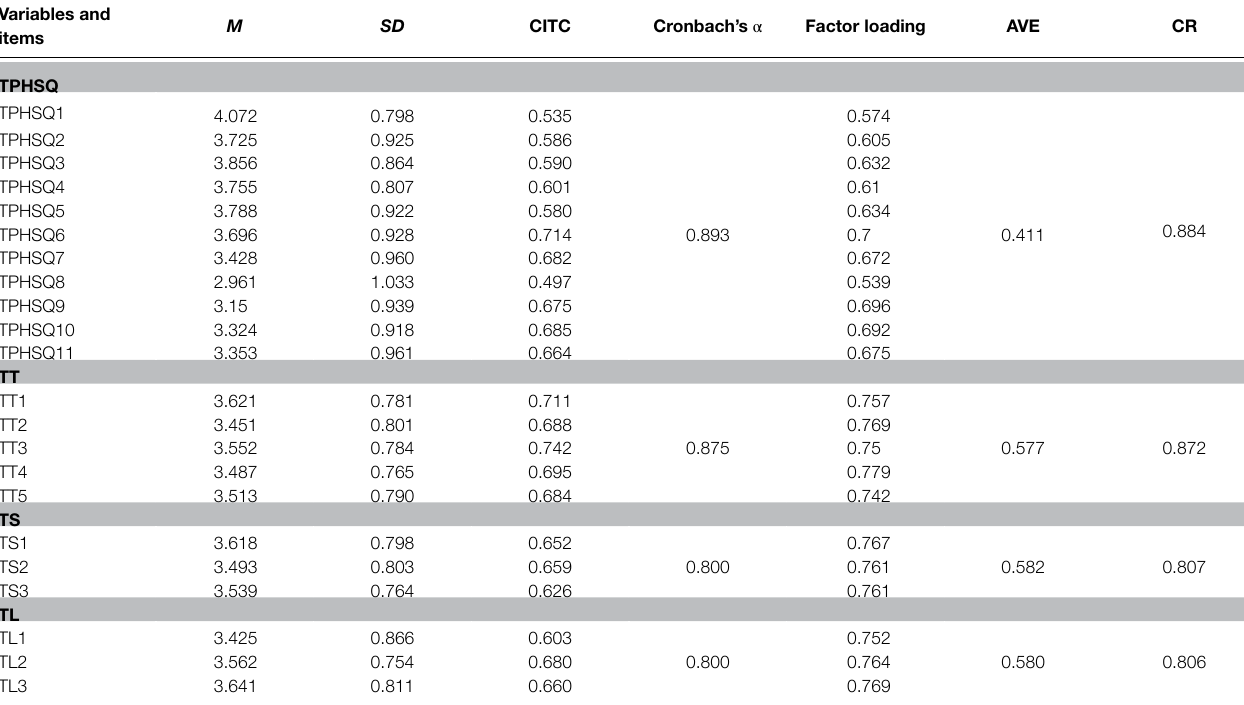
TABLE 3 | Confirmatory factor analysis (CFA) and reliability analysis. Variables and